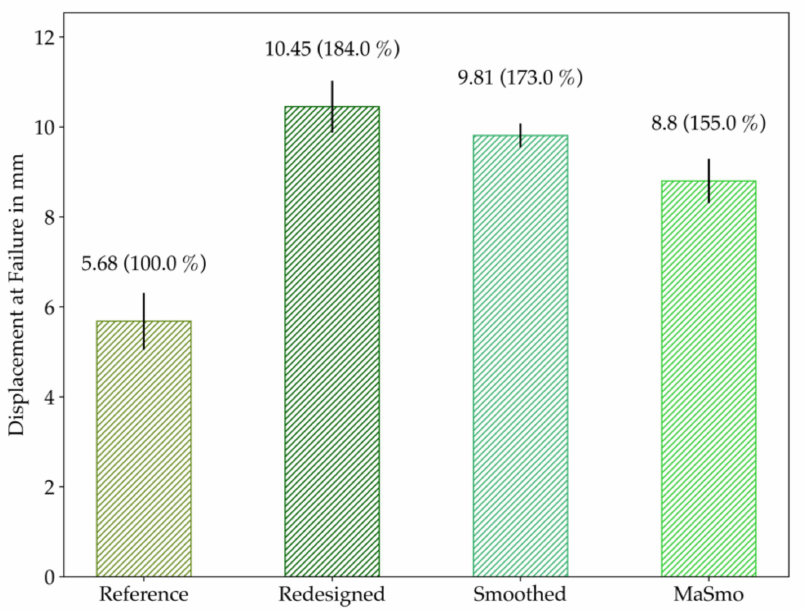
Figure 19. Comparison of the displacement at failure. The mean values are plotted together with the standard deviation. The difference from the reference is written in brackets in